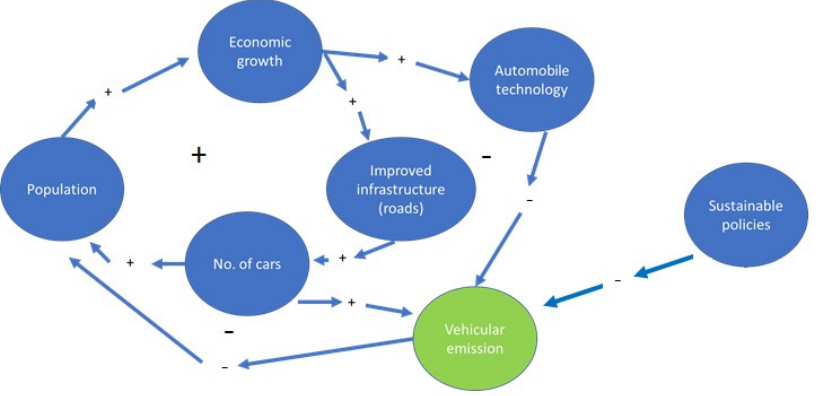
Figure 6. Causal loop diagram for vehicular emission.